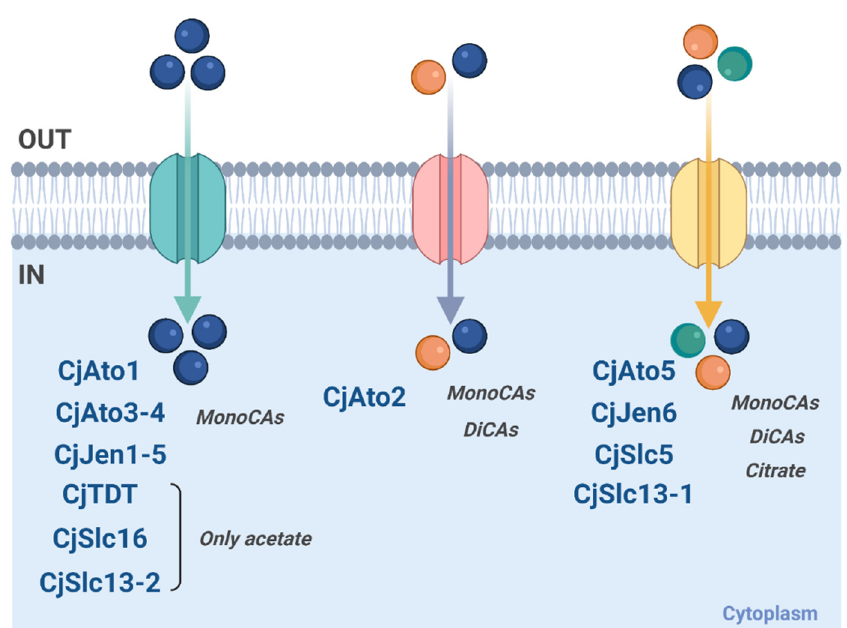
Figure 10. Carboxylic acid transporters from C. jadinii functionally characterized by heterologous expression in S. cerevisiae . Color circles represent the specificities uncovered for each of the protein-system: monocarboxylic acids—blue-filled circle; dicarboxylic acids—orange-filled circle; tricarboxylic acids—green-filled circle. IN—intracellular space; OUT—extracellular space. Created with biorender.com.